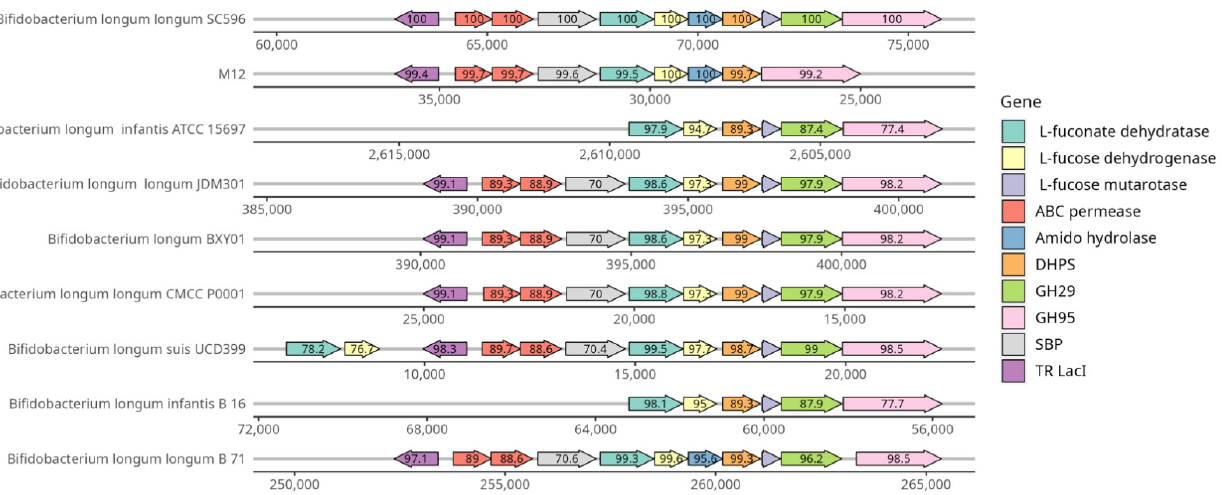
Figure 6. Locus map of carbohydrate use cluster identified in B. longum M12, and homologous B. longum subsp. longum genomes from public databases.